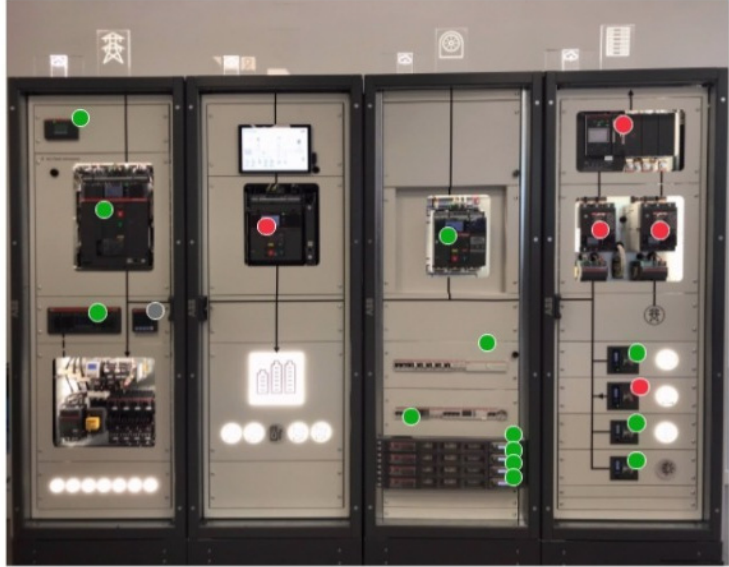
Figure 14. Visualization of the switchgear under constant online supervision.